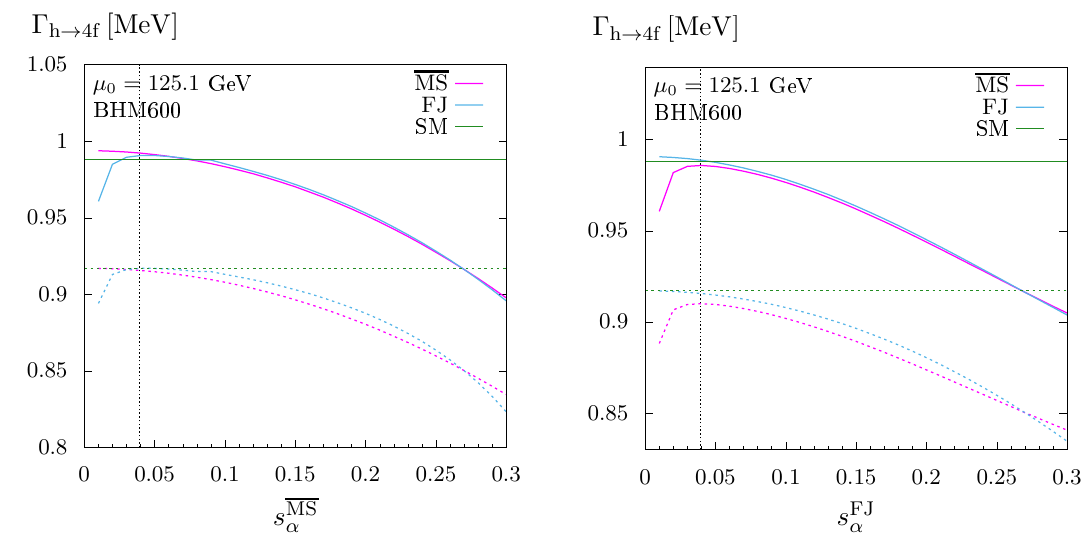
Figure 18 . Dependence of the decay width (cid:0) h ! 4 f at LO and NLO EW+QCD with respect to the variation of s (cid:11) . Free parameters other than s (cid:11) are (cid:12)xed according to benchmark scenario BHM600 (see table 2). On the left (right) the input parameters are de(cid:12)ned in the MS (FJ) scheme and converted to the FJ (MS) scheme (both for LO and NLO predictions). The vertical dashed line signals that for s (cid:11) . 0 : 04 perturbativity problems might arise.